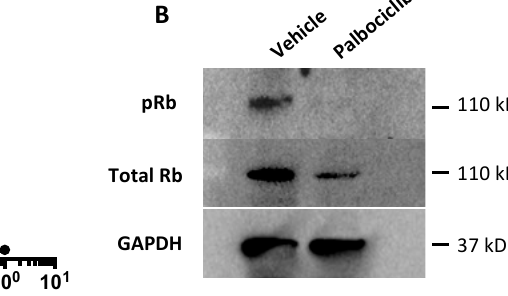
Figure 1. Palbociclib induces cell cycle arrest by inhibiting the phosphorylation of Rb in TNBC cell line. ( A ) Triple negative MDA-MB-231Luc2+GFP+ human breast cancer cells were treated with in- creasing concentrations (1 nM–1 mM) of palbociclib for 72 h after which an MTT proliferation assay was conducted. ( B ) Cells were treated with palbociclib at IC 50 (0.85 µM) or vehicle (sodium lactate) for 72 h and harvested for downstream analyses. Cell lysates were prepared for Western blot for the detection of pRb and total Rb protein. The original Western blot can be found at supplementary Figure S6. ( C ) Flow cytometry analysis of pRb protein (mean ± SEM compared to vehicle ( n = 3, *** p < 0.005; t -test). ( D , E ) Cells were treated with 0.85 µM dose palbociclib or vehicle for 72 h and cell 020 406080100